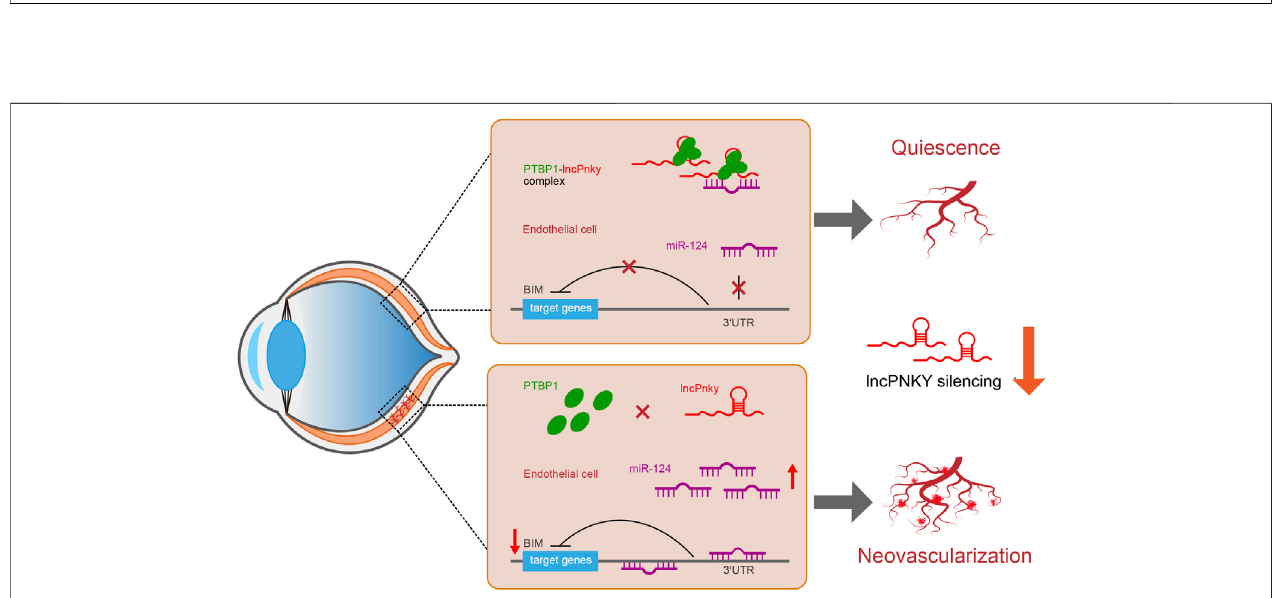
FIGURE 8 | Clinical relevance of cZBTB44 in CNV patients. (A,B) qRT-PCRs were performed to detect the level of PNKY and miR-124 in the AH of patients with ARC,glaucoma,andwetAMD. (C,D) qRT-PCRswereconductedtodetecttheexpressionofPNKYandmiR-124intheplasmafractionofpatientswithARC,glaucoma, and wet AMD ( n = 10, * p < 0.05 versus ARC and Glaucoma, Kruskal – Wallis ’ test followed by Bonferroni ’ s post hoc test).